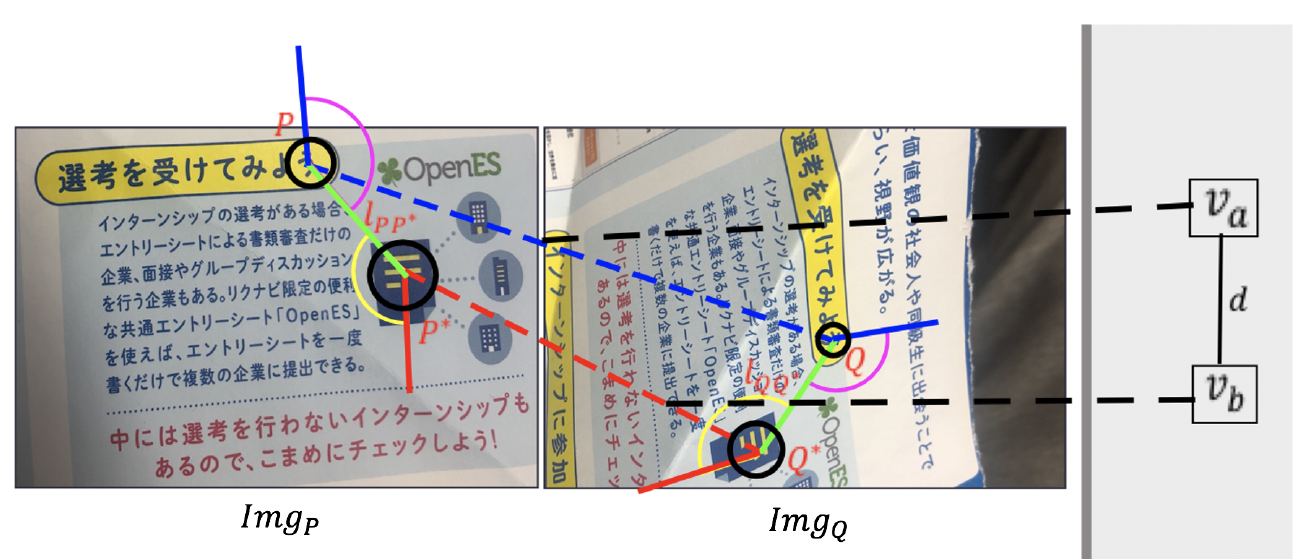
Figure 3. Two pairs of feature point